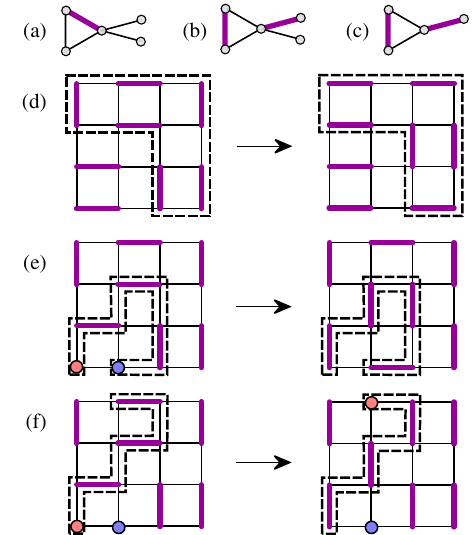
FIG. 5. (a) A maximal matching of a graph is a dimer covering such that no further edge can be covered with a dimer (purple) without causing a vertex (gray circles) to connect to two dimers. (b) A maximum matching additionally contains the maximum number of dimers. (c) If every vertex in a maximum matching connects to a dimer, the result is a perfect matching . (d) An alternating cycle is enclosed by the dashed line in this perfect matching of a bipartite graph. Augmenting the cycle (switching which edges are covered by dimers) results in another perfect matching. (e) Deleting one dimer results in a monomer- antimonomer pair. Augmenting paths are alternating paths with both ends terminating on monomers. Augmenting the path removes both monomers. No augmenting path can be present in a maximum matching. (f) An alternating path terminating on one monomer is highlighted. Augmenting the path moves the monomer. We term a minimal monomer move the augmentation of an alternating path of minimum length, which enacts a monomer hop across one unoccupied and one occupied